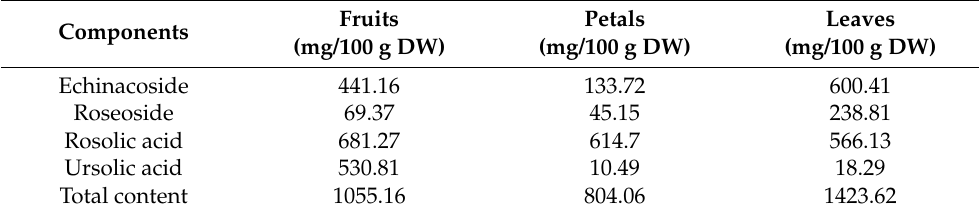
Table 5. Components and contents of triterpenoids acid in fruits, petals, and leaves of R. roxburghii [15].